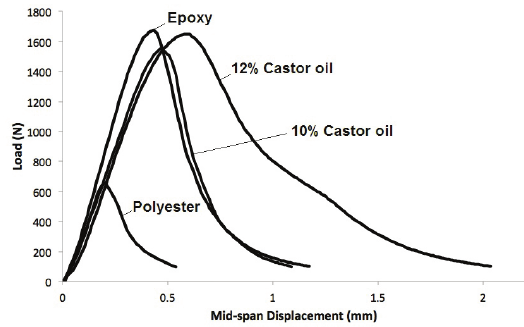
Figure 2. Typical flexural stress vs. strain of castor oil and synthetic polymer mortars.